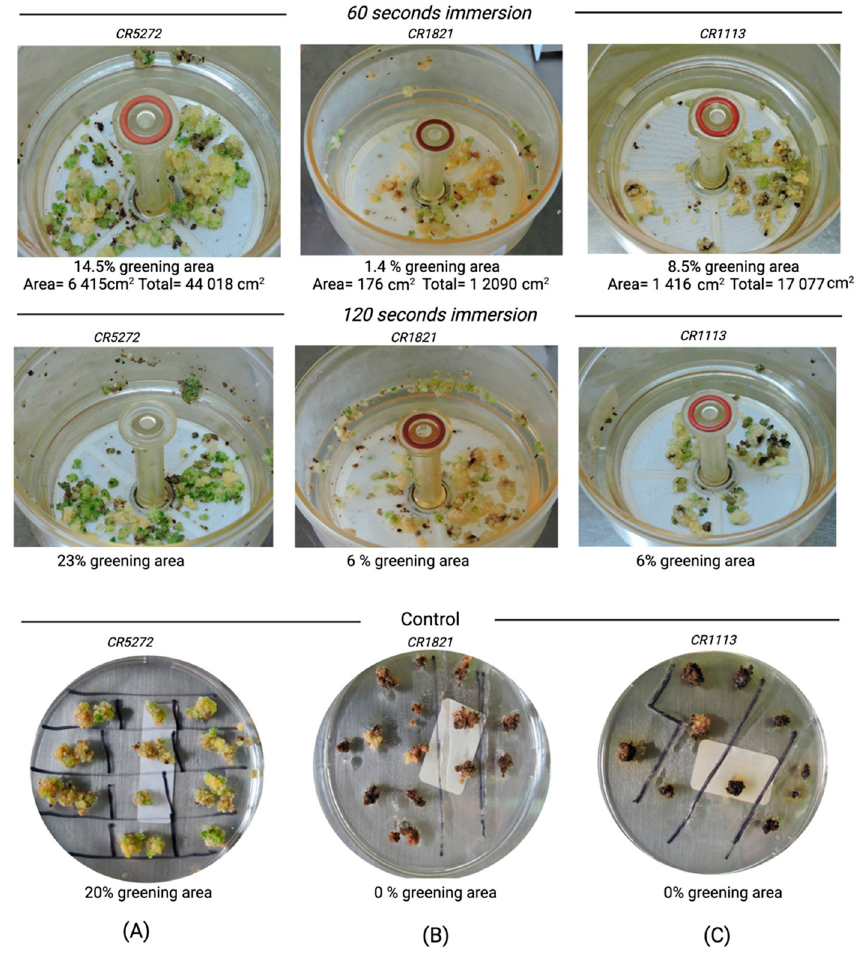
Figure 6. Regeneration of cultivars CR-5272 and recalcitrant CR-1821 and CR-1113 in MS medium with 0.5 mg L − 1 of NAA + 3 mg L − 1 of BA from calli induced with 2 mg L − 1 of 2,4-D. ( A ) CR-5272 regeneration in RITA with immersion for 30 s or 60 s, and the semisolid medium control. ( B ) CR-1821 regeneration in RITA with immersion for 30 s or 60 s and the semisolid medium control. ( C ) CR-1113 regeneration in RITA with immersion for 30 s or 60 s and the semisolid medium control. Note that all RITA treatments contain calli with green areas that regenerate into plants. The absence of regeneration of the recalcitrant cultivars CR-1821 and CR-1113 was observed in the semisolid media.